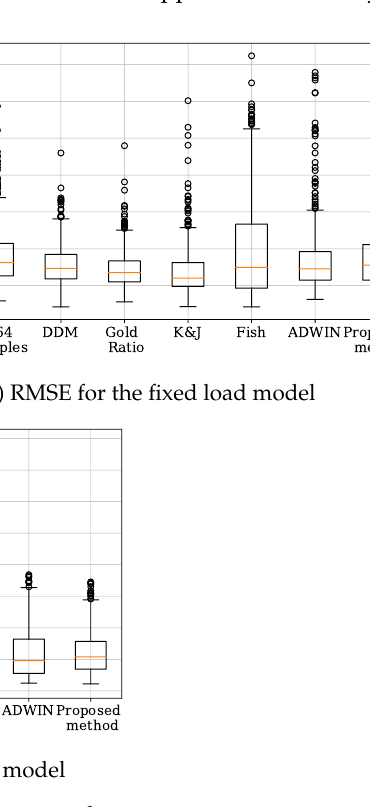
Figure 10. RMSE dispersion in the summer